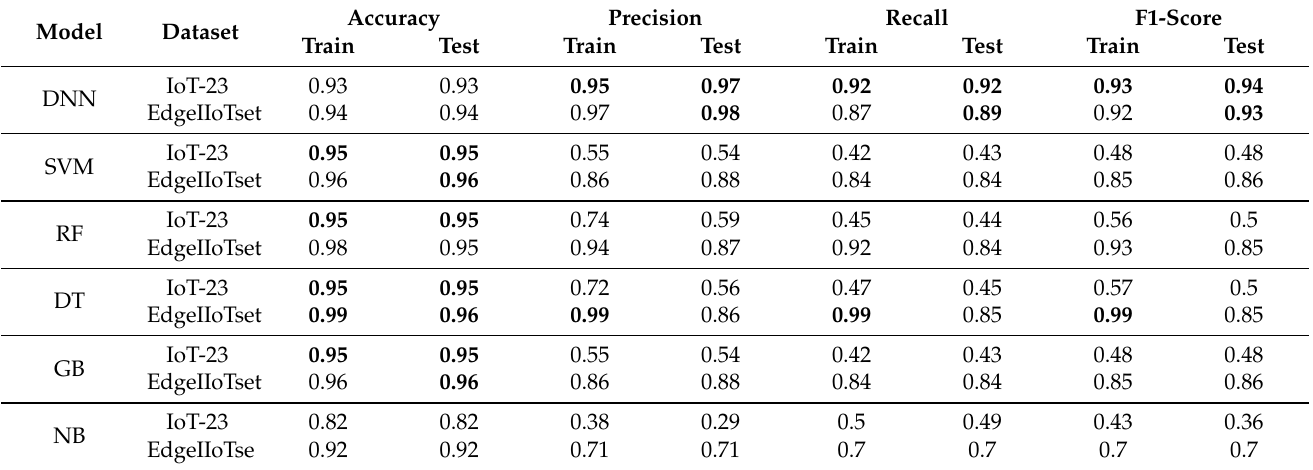
Table 2. Performance measures of different ML and DNN